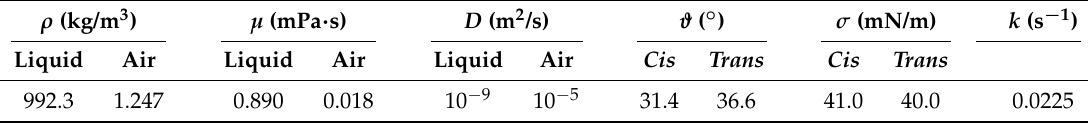
Table 1. Fluid properties: ρ , density; µ , viscosity; D , mass concentration diffusivity; ϑ , static contact angle on the solid wall; σ , surface tension; and k , reaction rate